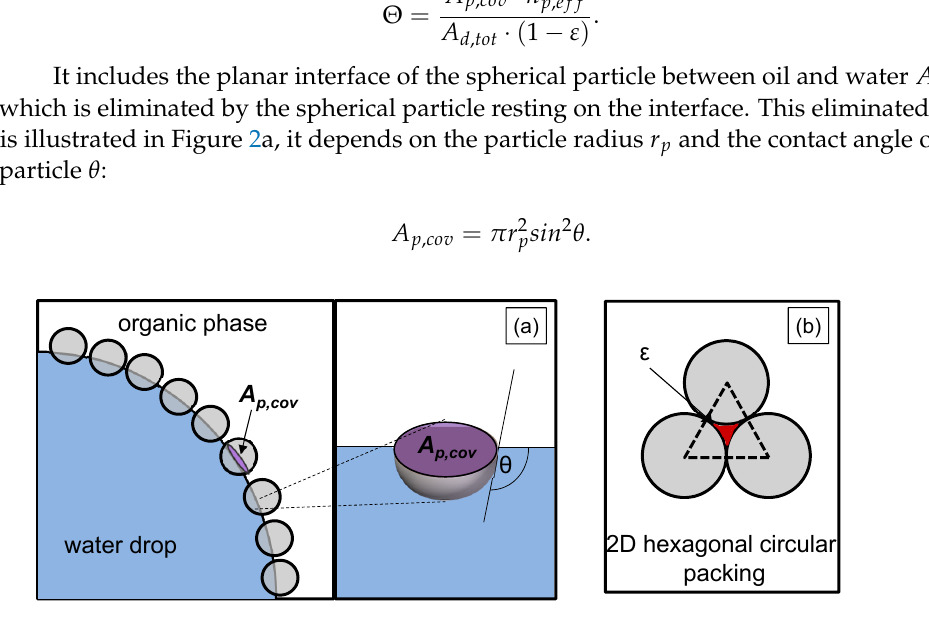
Figure 2. Illustration of ( a ) the planar interface A p , cov of a particle adsorbed at the liquid/liquid inter- face (purple marked), with a contact angle θ , ( b ) the void fraction ε of a hexagonal two-dimensional (2D) packed spherical particle layer (red